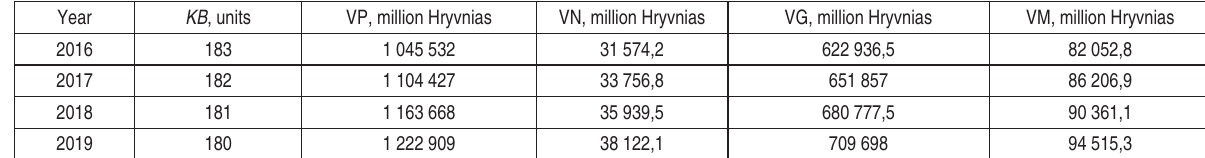
Table 7 into the built regression models (3 (cid:16) 7). The obtained projected values of the keyindicators of credit market of Ukraine are presented in Table8. Table 8. Forecast of key indicators of the credit market in Ukraine in 2016-2019 ( atthe beginningofthe period